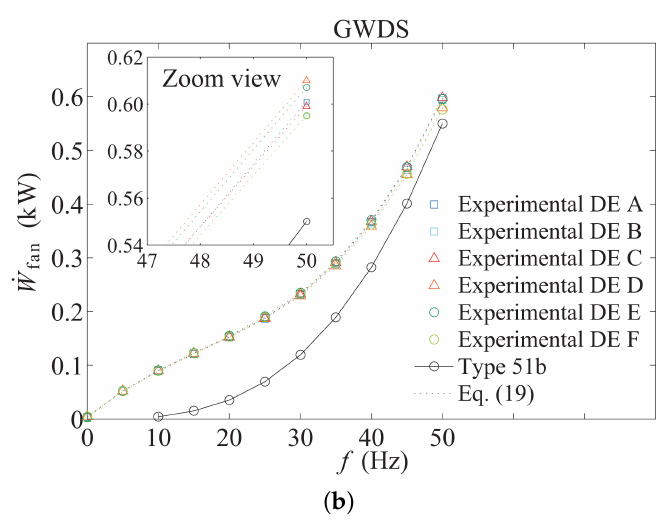
Figure 4. Experimental results for the power consumption of the fan as a function of f . Type51b prediction and proposed correlation. ( a ) Splash (pressure) water distribution system (PWDS) and ( b ) film flow (gravity) water distribution system